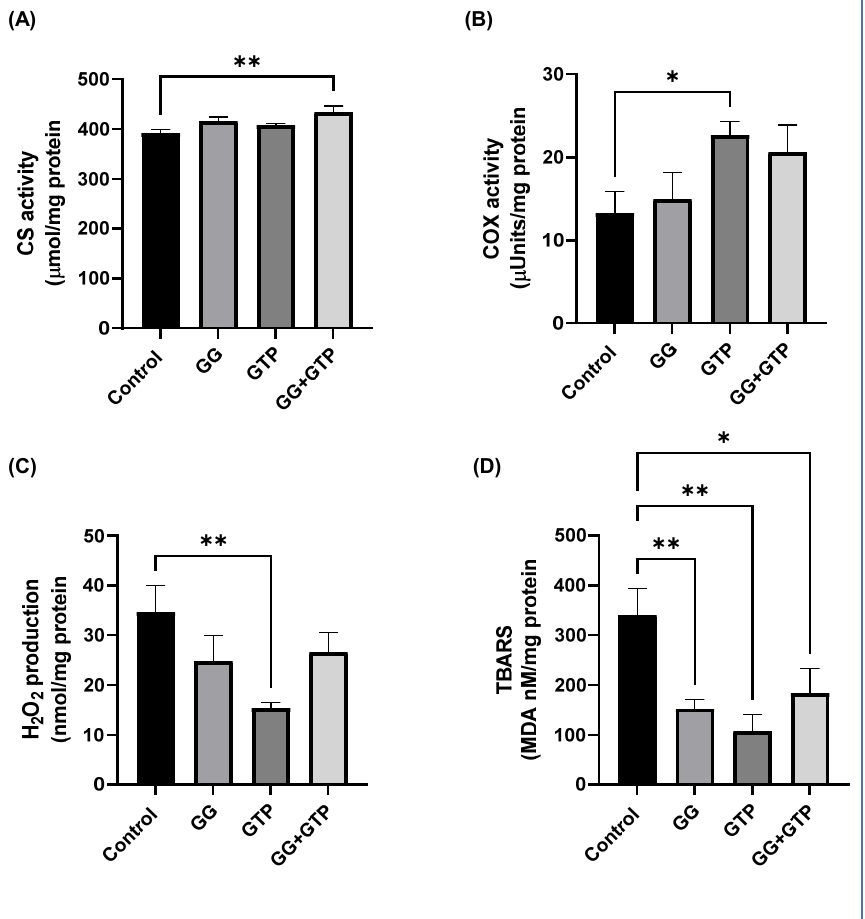
Figure 3. Effect of GGOH and GTPs on ( A ) CS activity, ( B ) COX activity, ( C ) H 2 O 2 production, and ( D ) TBARS level of the soleus muscle. Values are mean ( n = 6/group) with the standard error of the mean (SEM). CS, citrate synthase; COX, cytochrome c oxidase; Control, HFD only; GG, HFD supplemented with GGOH in 400 mg/kg diet; GTPs, HFD supplemented with 0.5% weight/volume GTPs in water; GG + GTPs, HFD supplemented with a combination of GGOH and GTPs; H 2 O 2 , hydrogen peroxidase; TBARSs, thiobarbituric-acid-reactive substances; MDA, malondialdehyde. *, p < 0.05; **, p < 0.01 by Fisher’s Least Significant Difference (LSD) test post hoc analysis.